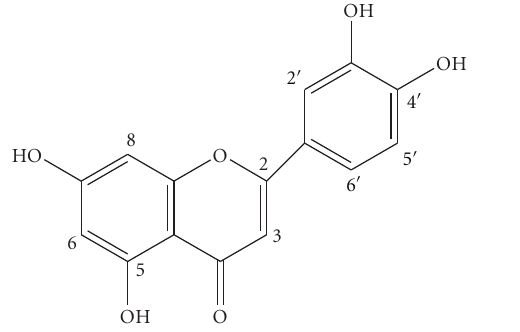
OH OH HH H O HO 2 H H H OOH F 2: e selected HMBC correlation of of 5,7-dihydroxy-2- (3,4-dihydroxyphenyl)-4H-chromen-4-one.